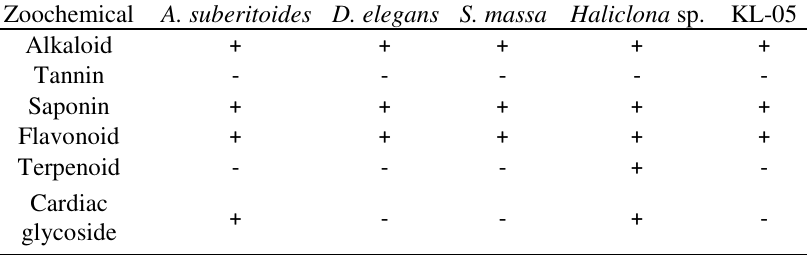
Table 1 . Zoochemical analysis results on the marine sponges